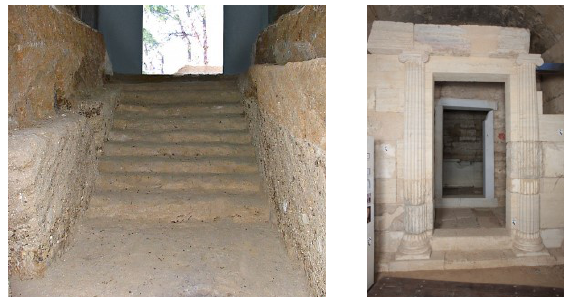
Figure 8: The staircase at the beginning of the dromos (left) and the monumental Ionic façade (right).